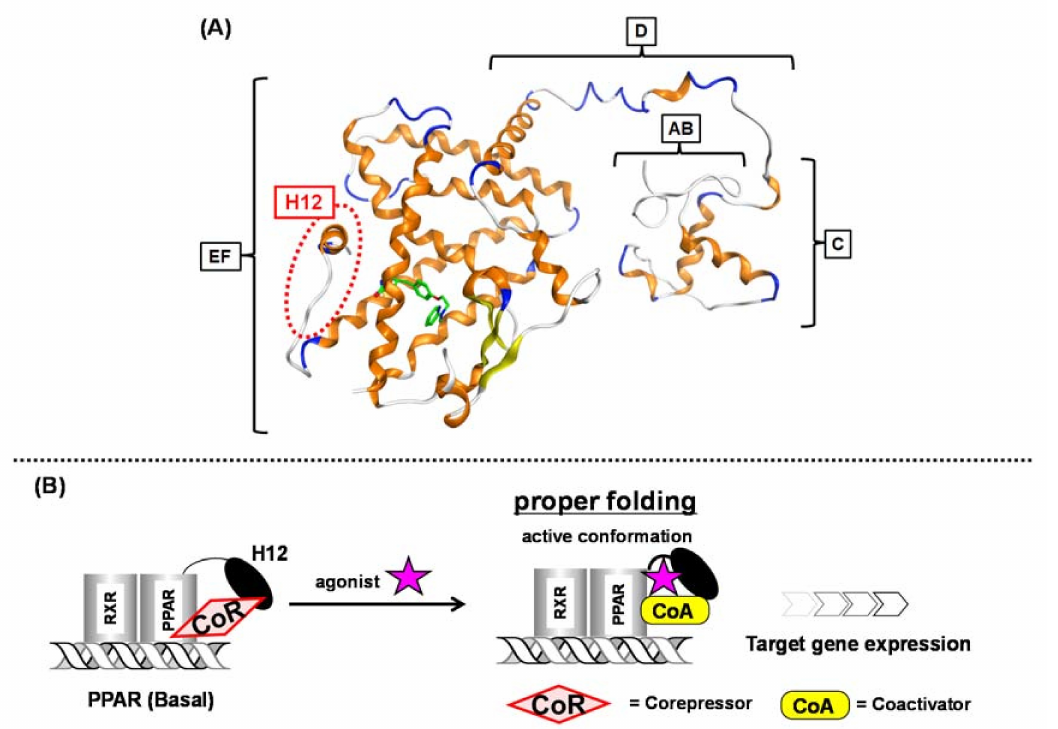
Figure 1. ( A ) Intact PPAR γ –rosiglitazone complex structure. A to F regions are depicted. The position of H12 (helix 12) is indicated with a red dotted circle. ( B ) Schematic representation of ligand-dependent nuclear receptor activation (PPAR as an example). PPAR forms a heterodimer with another nuclear receptor, RXR in the